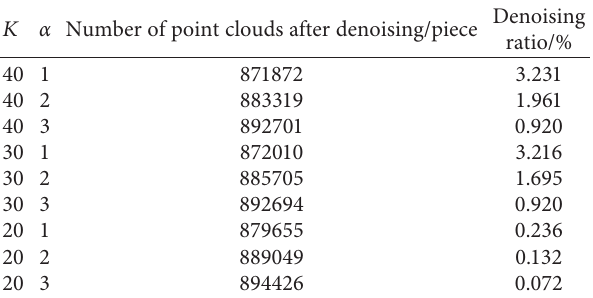
The number of point clouds before denoising is